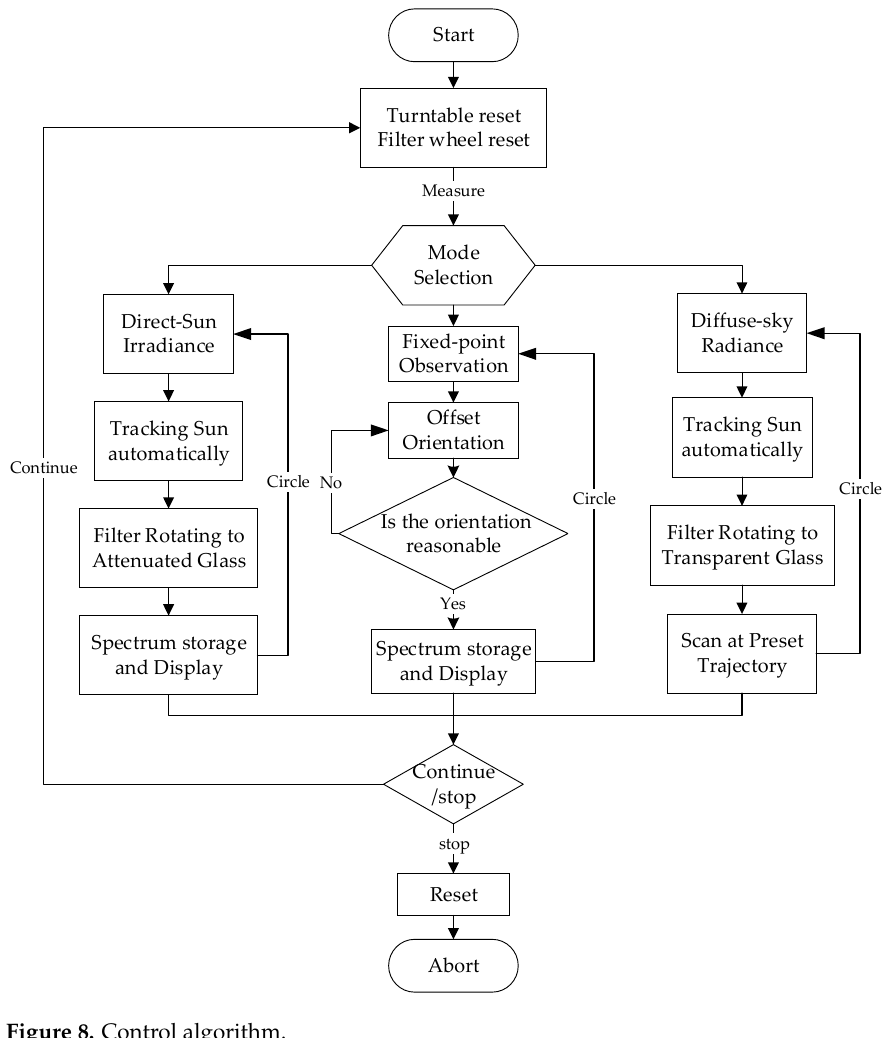
Figure 8. Control algorithm.